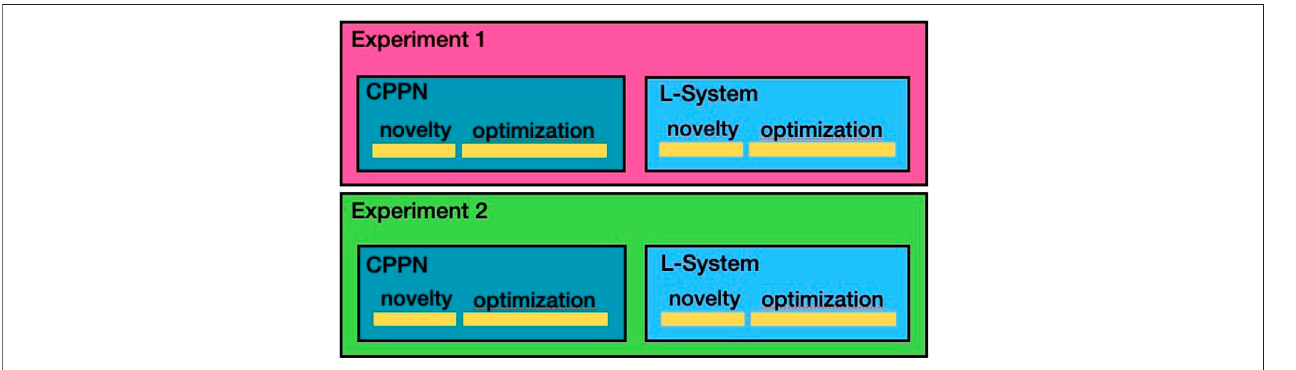
FIGURE 3 | Illustration of the experimental